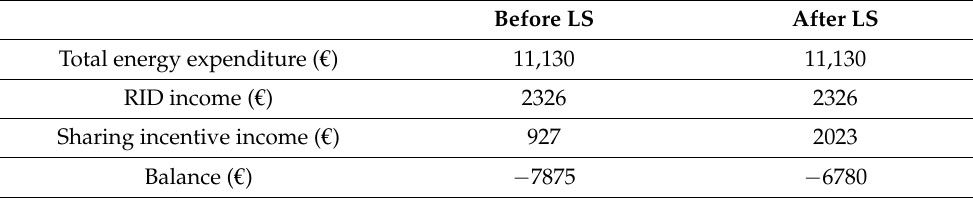
Table 10. Energy expenditure for the